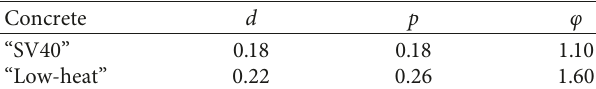
Table 4: Creep parameters for SV40 and low-heat concretes.